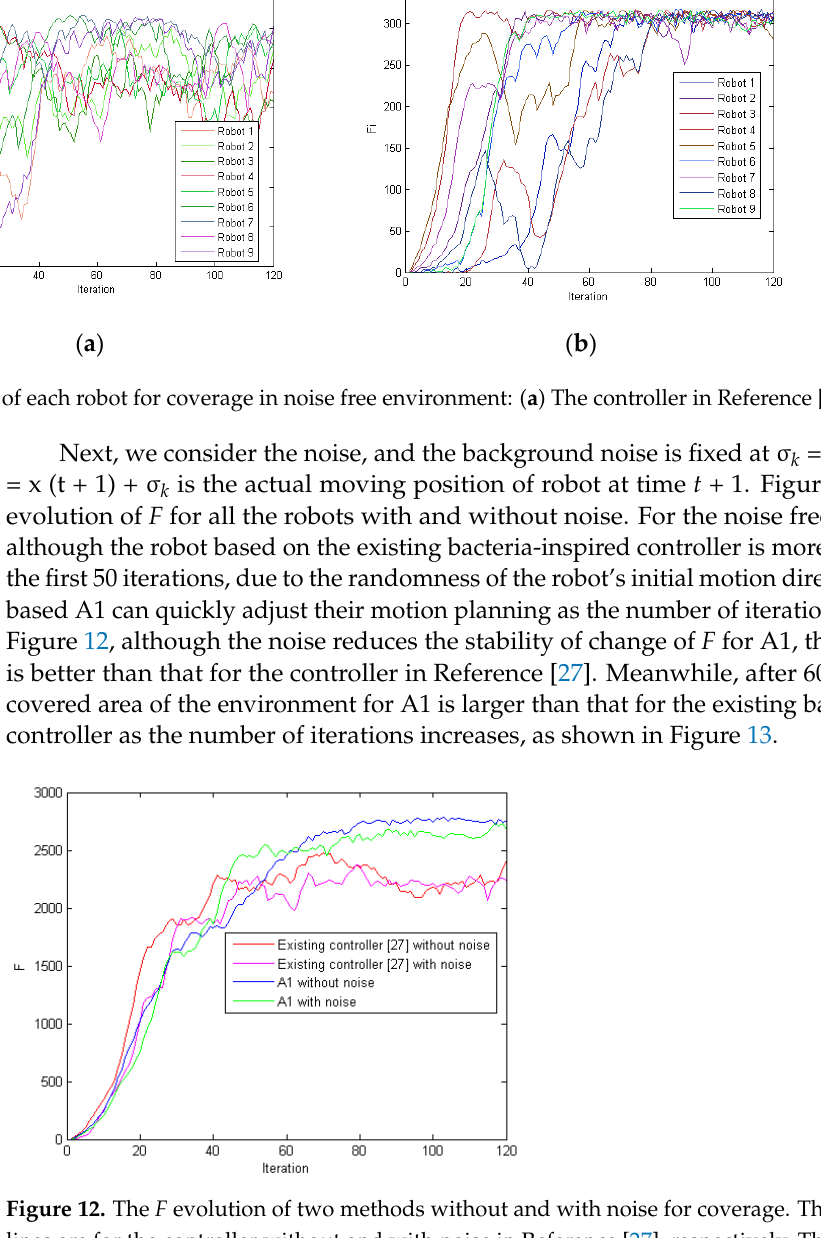
Figure 10. Simulation results for coverage in noise free environment: ( a – f ) The controller in Refer- ence [27]; ( g – l ) A1.